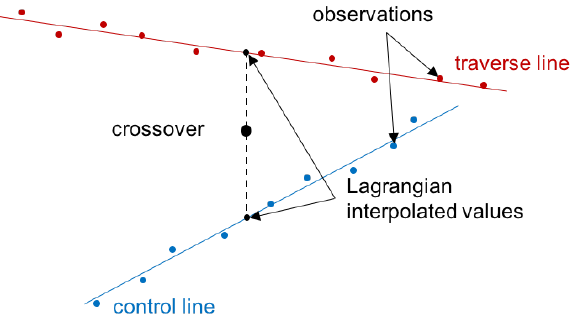
Figure 3. Geometry of the crossover analysis.